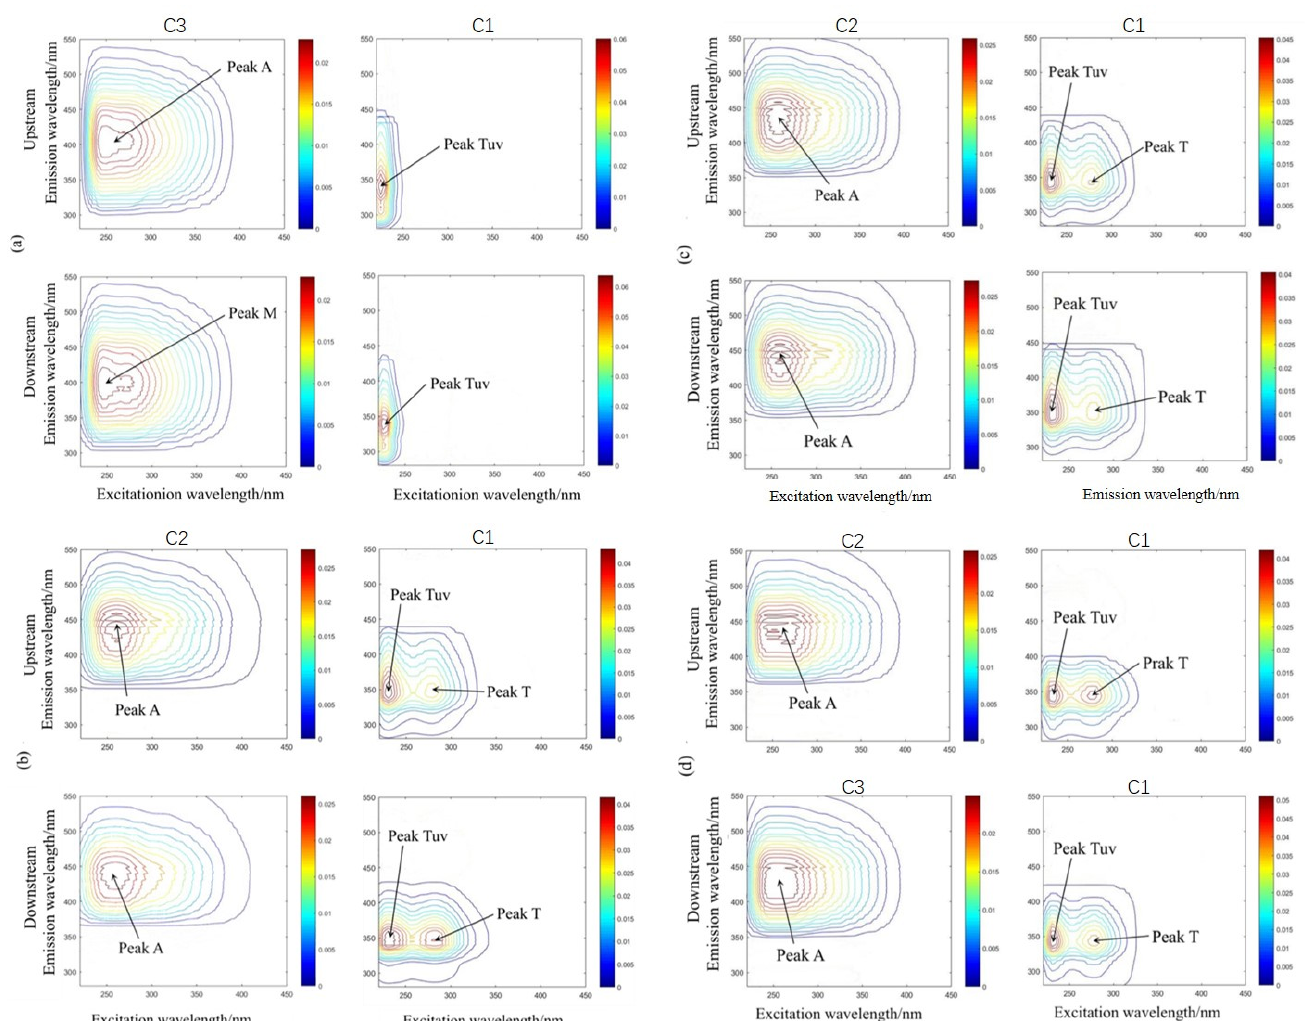
Figure 3. Identification of fluorescent components in water in the TNRs watershed. ( a ) Shows the fluorescent components in spring (C1 + C3); ( b ) shows fluorescent components in summer (C1 + C2); ( c ) shows fluorescent components in autumn (C1 + C2); and ( d ) shows fluorescent components in winter (C1 + C2 for upstream; C1 + C3 for downstream).